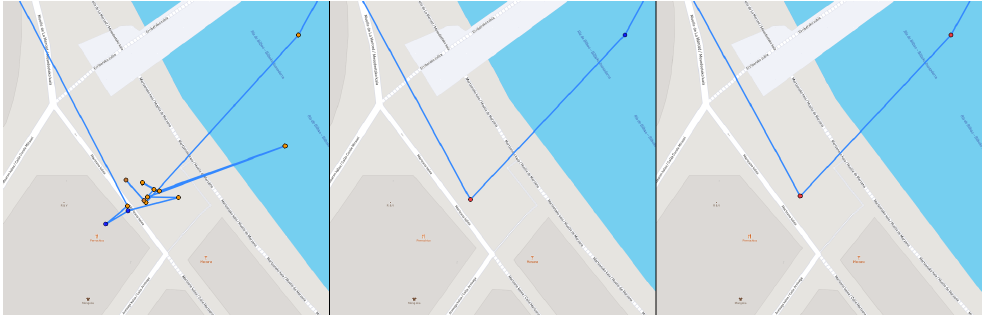
Figure 7. Static-drifts resolution. Raw ( left ), first iteration ( center ), second iteration ( right